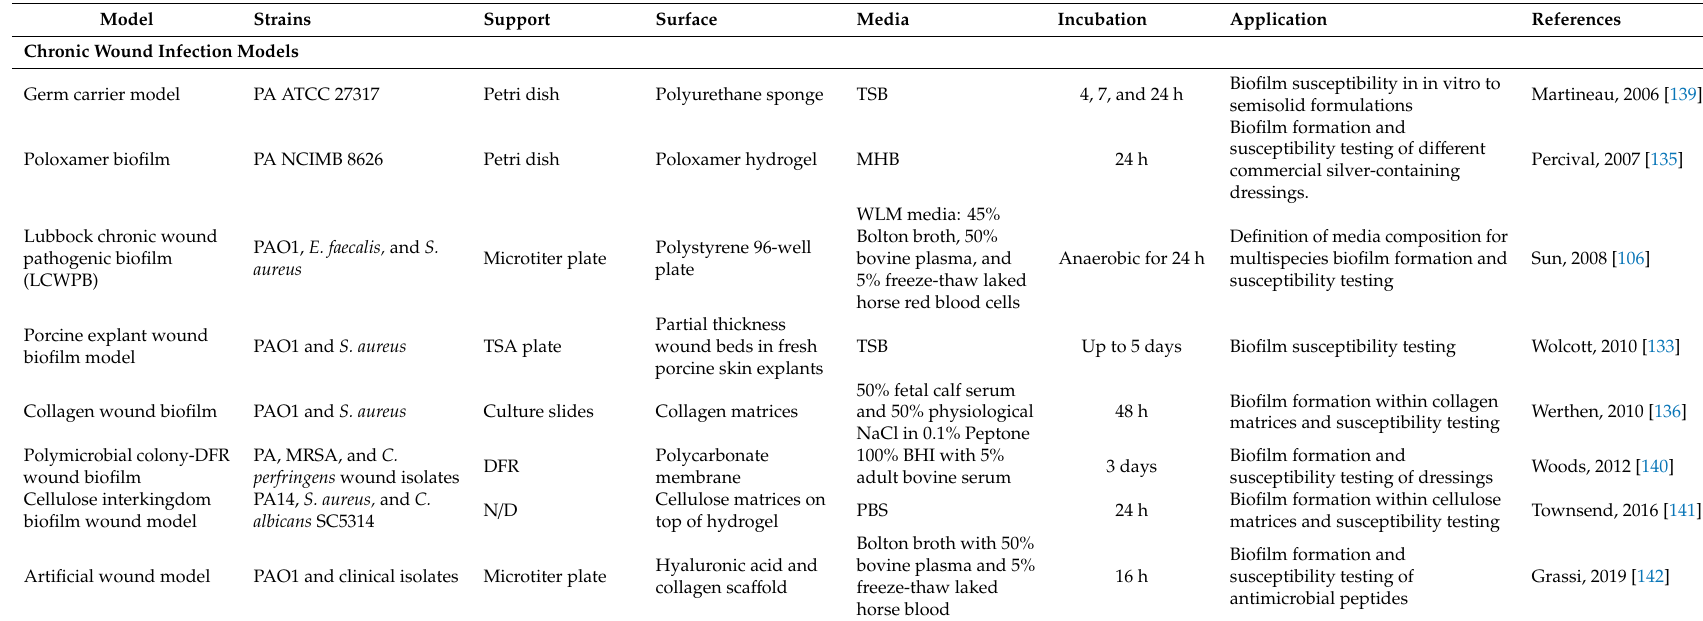
Table 1. Advances in models to study Pseudomonas aeruginosa biofilms in